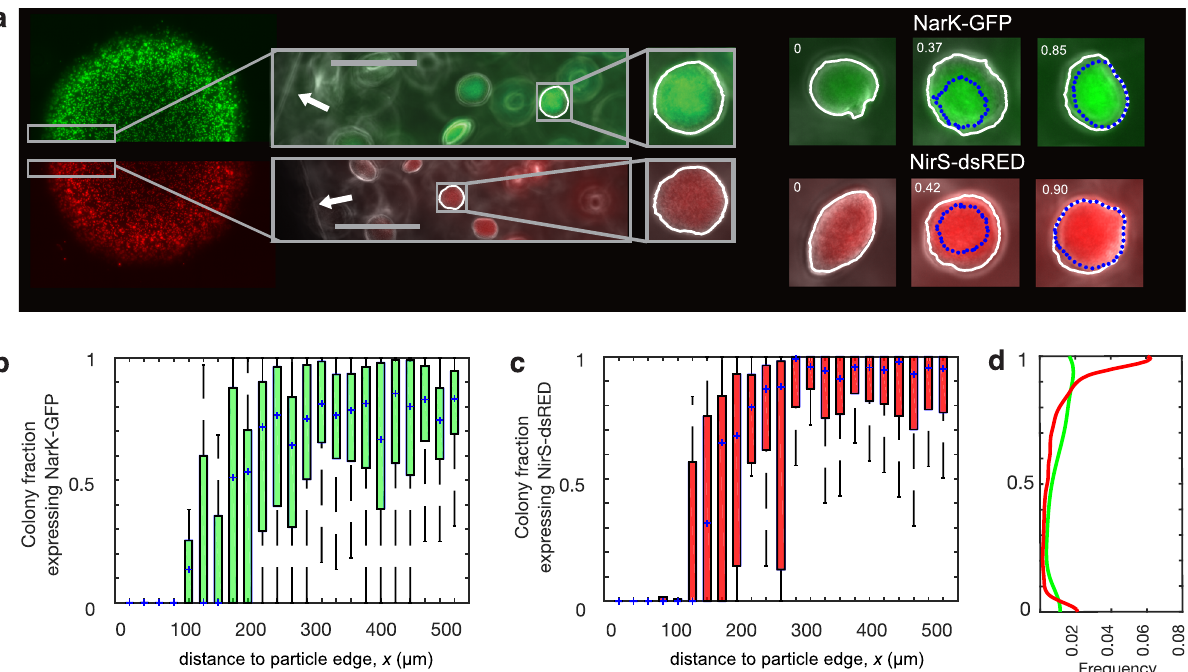
Fig. 5 Heterogenous denitri fi cation gene expression within individual microcolonies. a PAO1 NarK-GFP (top) or NirS-dsRed (bottom) were grown in separate particles in LB media saturated with 50% air and supplemented with 40 μ M NO 3 – . Arrows indicate the particle edge; scale bars = 100 μ m. For hundreds of microcolonies, the fraction expressing either NarK or NirS was quanti fi ed, and example microcolonies (right) illustrate ‘ on ’ fractions ranging from 0 to 0.90, with ‘ on ’ subregions noted by blue dotted lines. b Microcolony fraction expression for NarK-GFP and c NirS-dsRed, as a function of distance to the nearest particle edge. Shown are the median (blue crosses) and quartiles binned over 25 μ m of radial particle space. Colonies were primarily ‘ off ’ in the aerated zone nearest bulk fl uid ( x < 100 μ m) and primarily ‘ on ’ in anoxic conditions ( x > 250 μ m). In the aerobic zone, the median expression fraction of NarK-GFP is 3.1 × 10 − 5 (interquartile range 5.5 × 10 − 5 ) whereas the NirS-dsRed expression fraction is 2.7 × 10 − 5 (interquartile range 1.5 × 10 − 5 ). Expression of both genes are not signi fi cantly different from each other (Wilcoxon rank sum; p = 0.1). In the anaerobic zone, the median expression fraction of NarK-GFP and NirS-dsRed are 0.70 (interquartile 0.39) and 0.94, (interquartile 0.24), respectively. These anoxic fractional expressions are signi fi cantly different from each other (n 1 = 1160, n 2 = 1078, Wilcoxon rank sum; p = 2.2 × 10 − 32 , w = 2724). The occurrence of heterogenous partially-on microcolonies re fl ects a sharp transition zone between presumptive aerobic and anoxic conditions ( x ~ 100 – 250 μ m). d Probability density functions for each reporter strain indicate stronger bimodality and higher binary expression for NirS-dsRed than for NarK-GFP. The distribution of NarK v. NirS expression are signi fi cantly different from each other (two sample Kolmogorov – Smirnov test; n 1 = 1554, n 2 = 1354 p = 1.2 × 10 − 40 , Dn = 0.25) with signi fi cantly different medians (n 1 = 1554, n 2 = 1354, Wilcoxon rank sum; p = 1.9 × 10 − 33 , w = 1.9 × 10 6